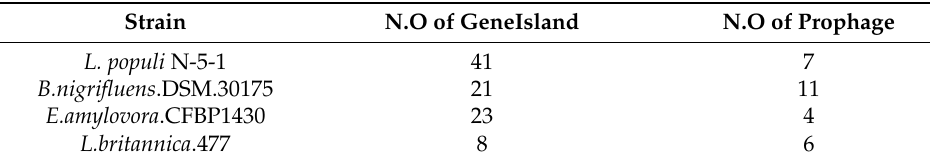
Table 4. Distribution of mobile genetic elements in the N-5-1 genome.